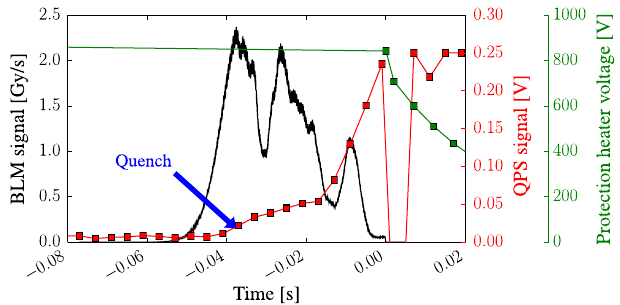
FIG. 9. BLM (black) and QPS (red) signals registered during the orbit-bump quench test with intermediate loss duration. A drop in QPS heater-voltage indicates heater firing (green), which was synchronized with the moment of beam dump. The QPS signal measures resistive voltage in a magnet. The 0.1-V intercept of the QPS signal was timed to precede the heater firing by 10 ms, i.e., the QPS evaluation time.